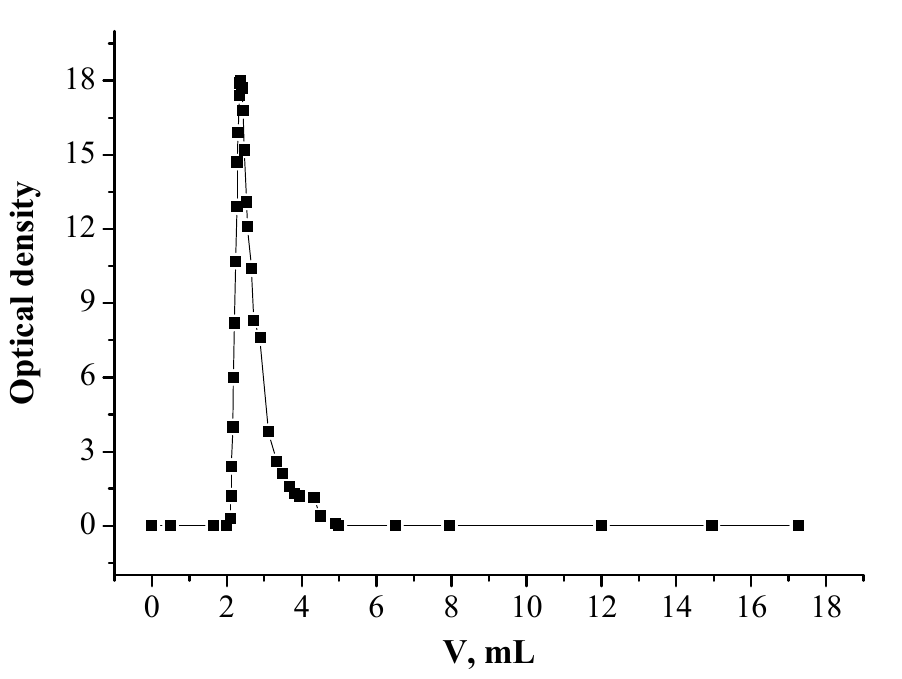
Figure 8. Stripping of Nd(III) with EDTA solution.